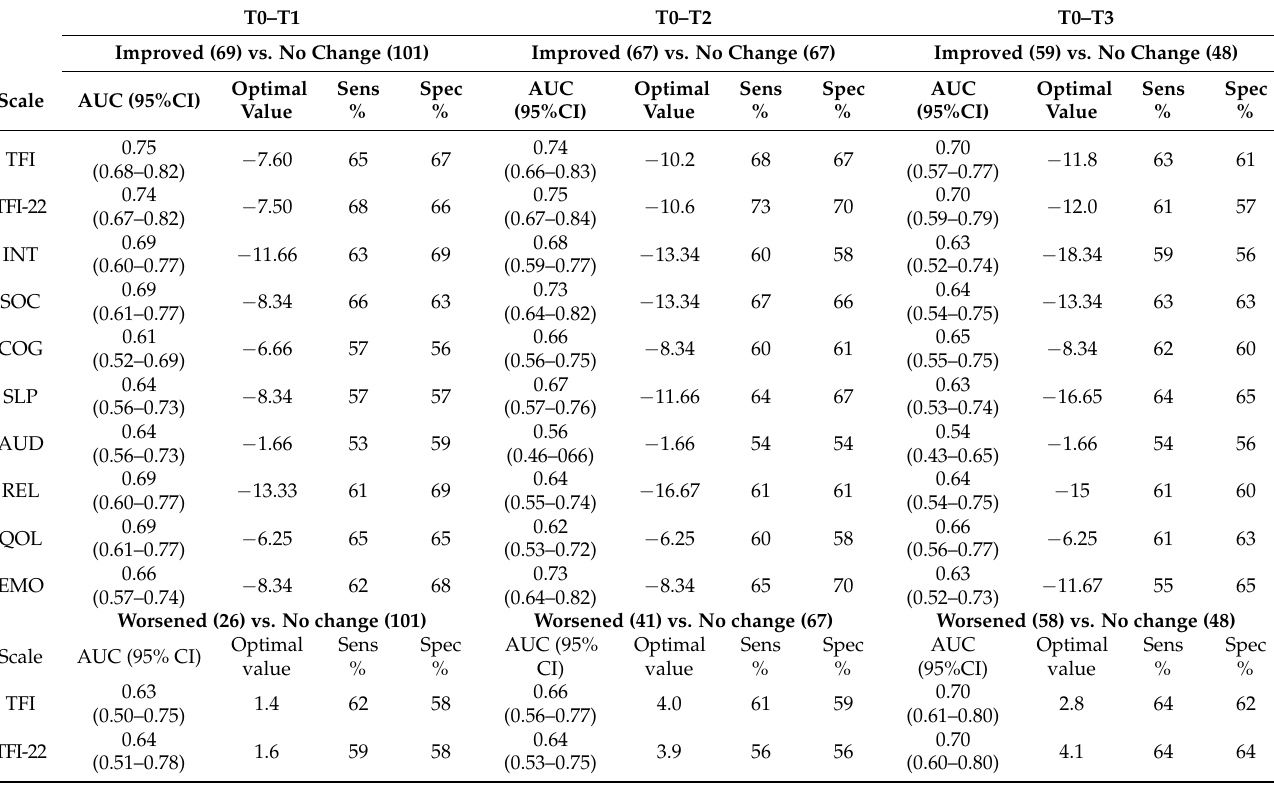
Table 4. Characteristics of the Receiver Operating Characteristic (ROC) analysis and the optimum cut-off point for TFI-25, TFI-22 and subscales for detecting improvements and worsening of tinnitus impact across all